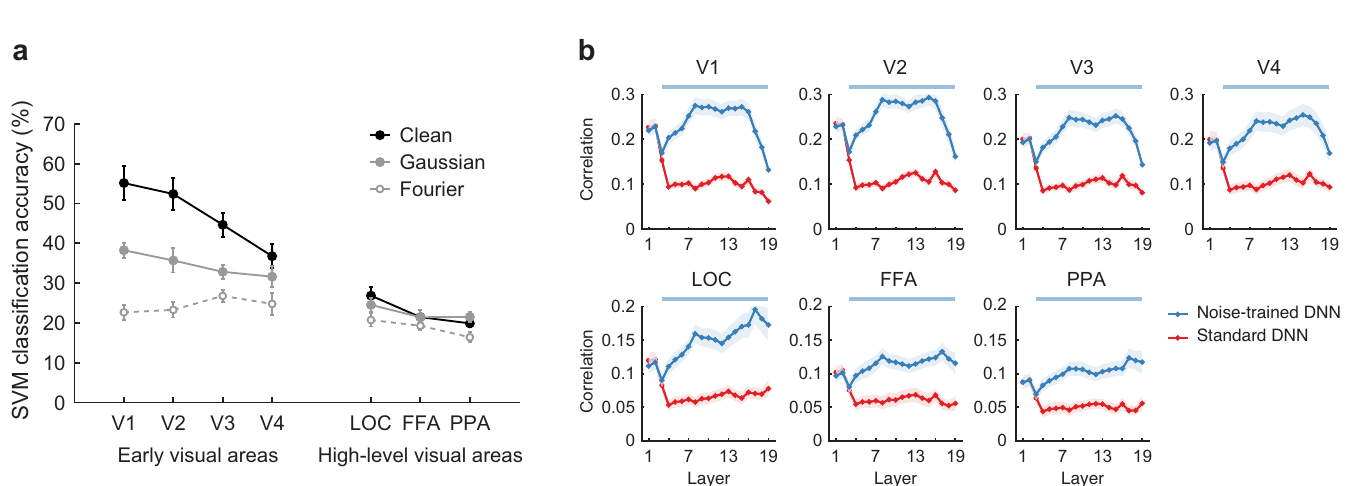
Fig 7. Noise-trained VGG-19 provides a better model of human cortical responses to objects in noise. (a) Classification accuracy for fMRI responses in individual visual areas for clean objects (black filled circles), objects in pixelated Gaussian noise (gray filled circles) and Fourier phase-scrambled noise (gray open circles). Error bars indicate ± 1 standard error of the mean ( n = 8). Chance-level performance is 12.5%. (b) Correlational similarity of object representations obtained from human visual areas and individual layers of DNNs when comparing standard versus noise-trained networks (red versus blue, respectively). Color-coded horizontal lines at the top of each plot indicate a statistically significant advantage ( p < 0.01 uncorrected) for a given DNN at predicting human neural representations of the object images. Data are available at https://osf.io/bxr2v/. DNN, deep neural network; FFA, fusiform face area; fMRI, functional magnetic resonance imaging; LOC, lateral occipital cortex; PPA, parahippocampal place area; SVM, support vector